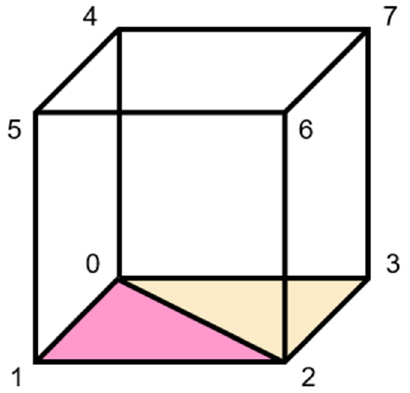
Figure 4. Vertex order of the 3D object: the number indicates the order of vertices to build 3D object. Once the positions of vertex number 0–3 are determined, then the position of vertex 4–7 are computed automatically from the height parameter.